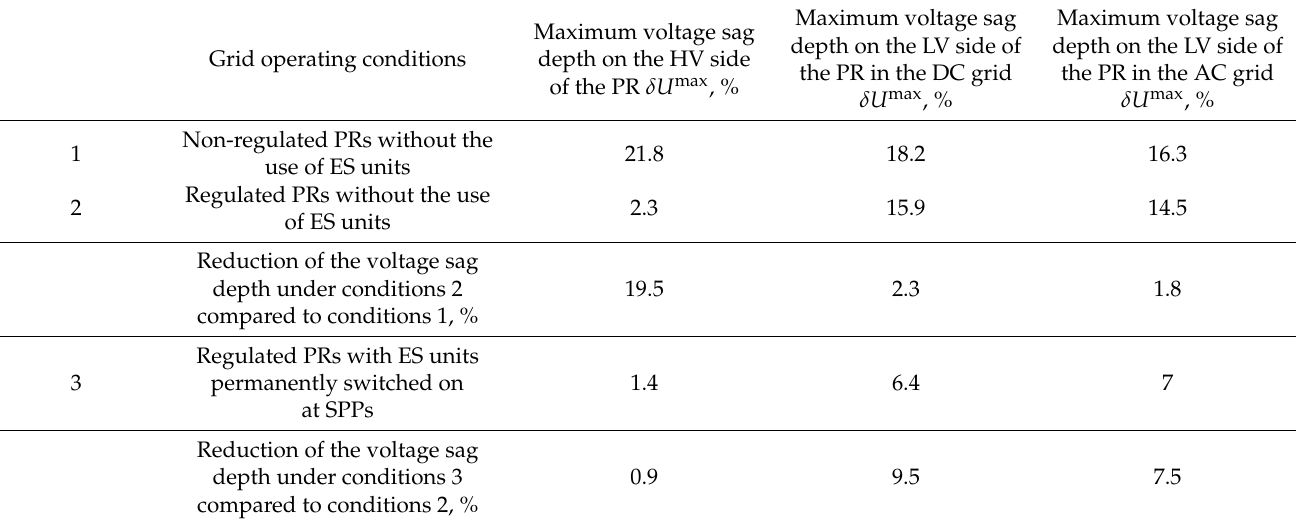
Table 1. Results of simulation of the voltage sag when the power supply system was switched